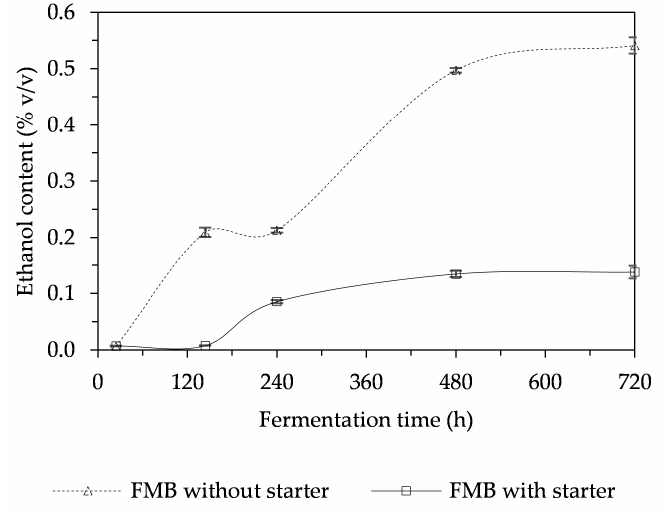
Figure 4. The change of ethanol content in a fermented mushroom beverage (FMB) with and without starter culture L. plantarum SK15 during fermentation time.